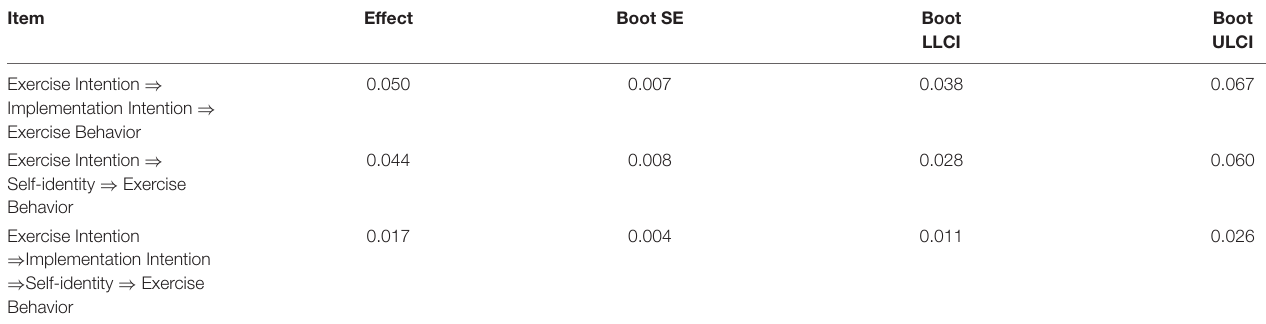
TABLE 5 | Analysis of mediating effects between implementation intention and self-identity. Item